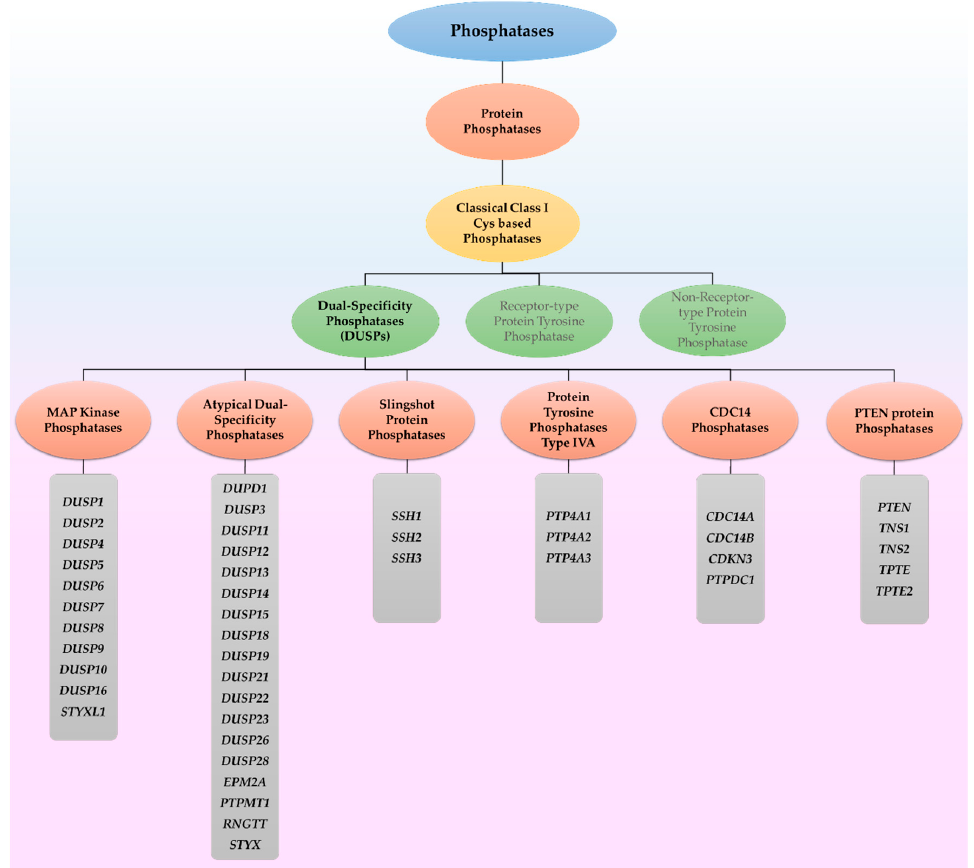
Figure 1. The schematic classifications of human dual-specificity phosphatases. Phosphatases are classified into seven gene families, of which Protein Phosphatases are one. They are further categorized into five groups, which includes Class I classical Cys-based Phosphatases. This group is then subdivided into dual-specificity phosphatases, Receptor-type Protein Tyrosine Phosphatases, and Non-receptor-type Protein Tyrosine Phosphatases. Dual-specificity Phosphatases are categorized by six subfamilies: (i) Mitogen-activated Protein Kinase Phosphatases (MKP); (ii) Atypical DUSPs; (iii) Slingshot Protein Phosphatases; (iv) Protein Tyrosine Phosphatases type IVA; (v) CDC14 Phosphatases and (vi) PTEN Protein Phosphatases. Members of each subfamily are as listed in the figure. Data are adapted from the HUGO Gene Nomenclature Committee at the European Bioinformatics Institute, http://www.genenames.org/.